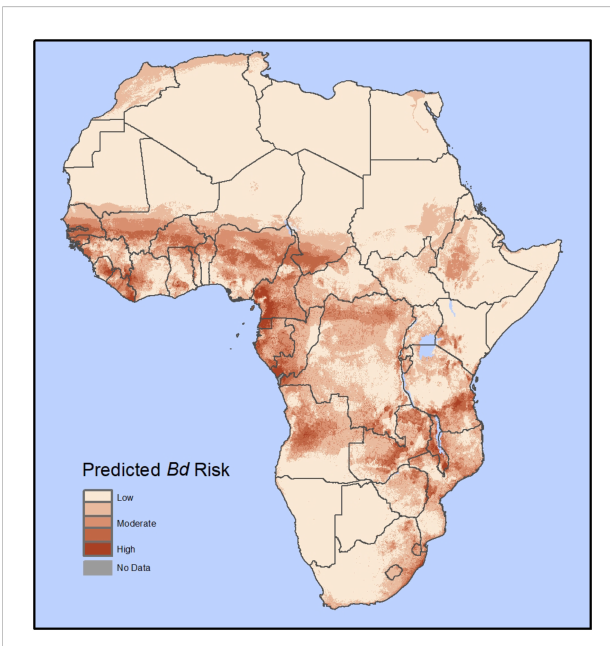
FIGURE 3 Predicted Bd disease risk in Africa from our habitat suitability model (HSM); Based on 1,914 georeferenced Bd occurrence records with 195 unique Bd -positive localities in the African mainland and islands in the Gulf of Guinea. The Bd risk model is a product of a Bd HSM model (similar to Yap et al. (2018); here using 10 bioclimatic variables and the global human footprint as predictor variables) and host richness maps (AmphibiaWeb) for the entire African continent. The results are shown on a color scale from low risk (tan color) to high risk (red